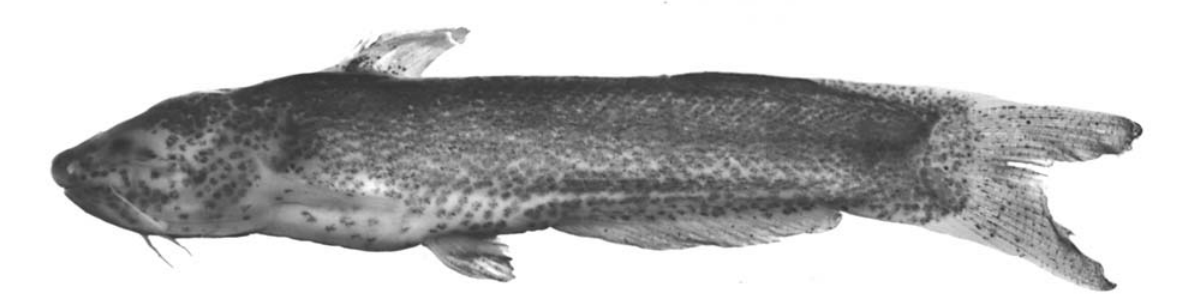
Fig. 7. Cetopsidium orientale, holotype of Pseudocetopsis orientale , MHNG 2621.040, 27 mm SL; Suriname, Brokopondo District, Mindrineti Kreek, close to mouth of Maykaboeka Kreek, Saramacca River basin, on Gros Rosevel Mining concession (5°07’08.8"N,